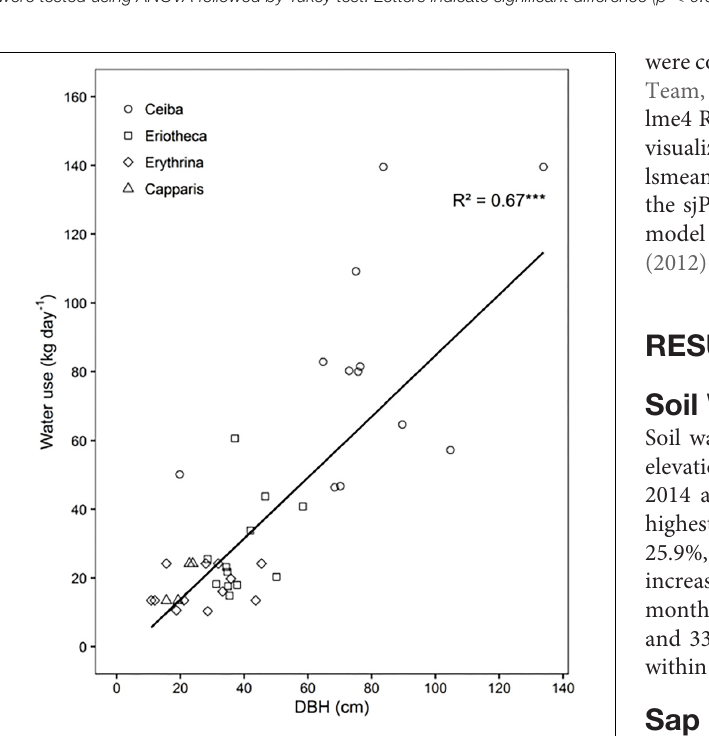
VPD:species, VPD:elevation and species:elevation.